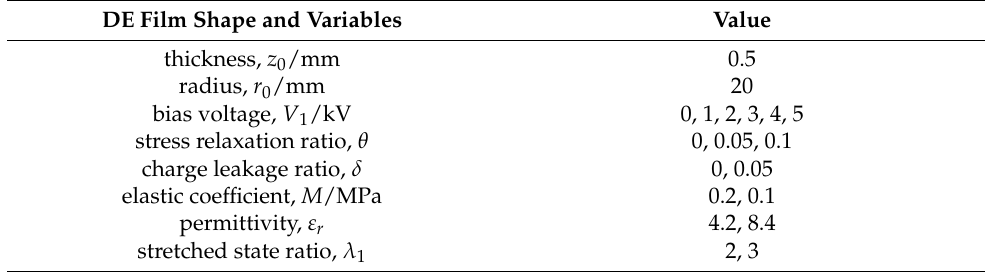
Table 1. Summary of the shape of the DE film and variables in this